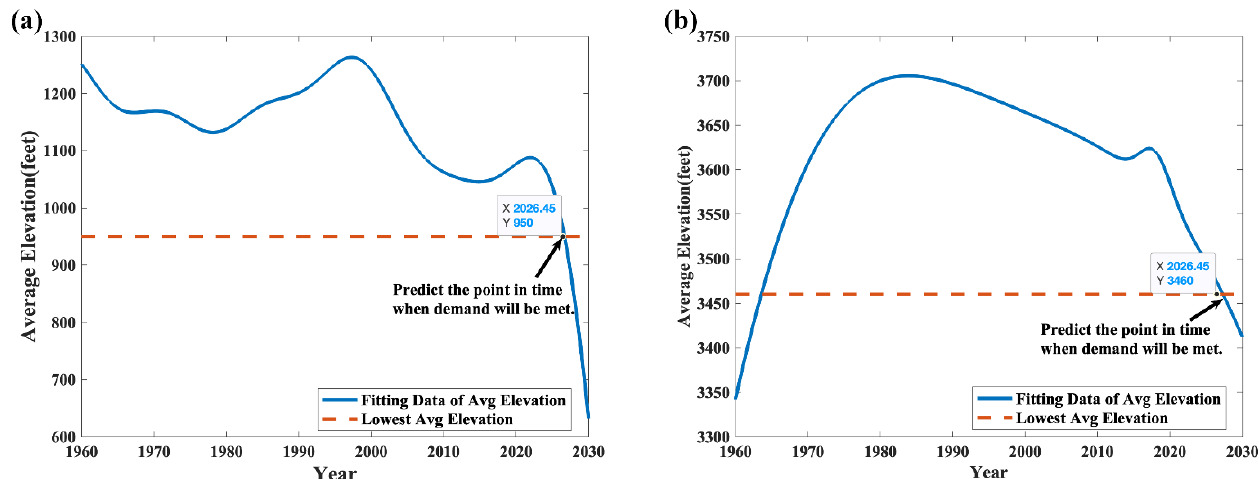
Figure 12. The Results of Fitting and Predicting of the Water Elevations at the dam. ( a ) The HD. ( b ) The GCD.